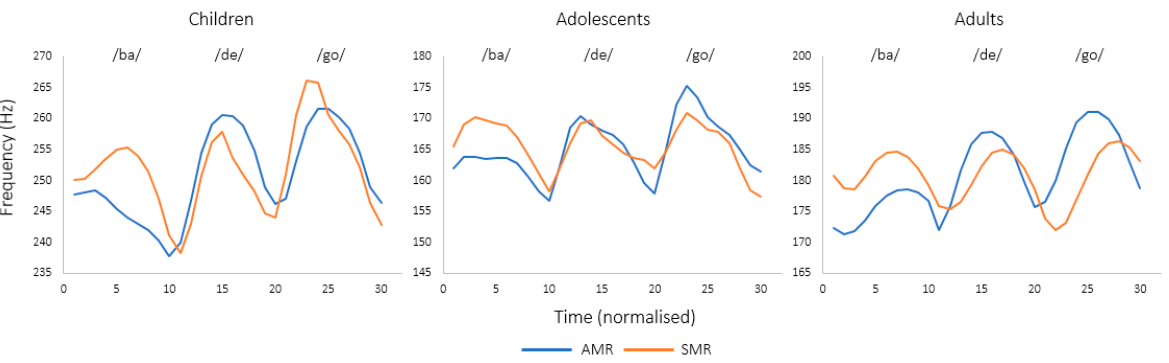
Figure 3. f o contours for the averaged /ba/, /de/ and /go/ syllables from the AMR and SMR tasks in children, adolescents and adults.